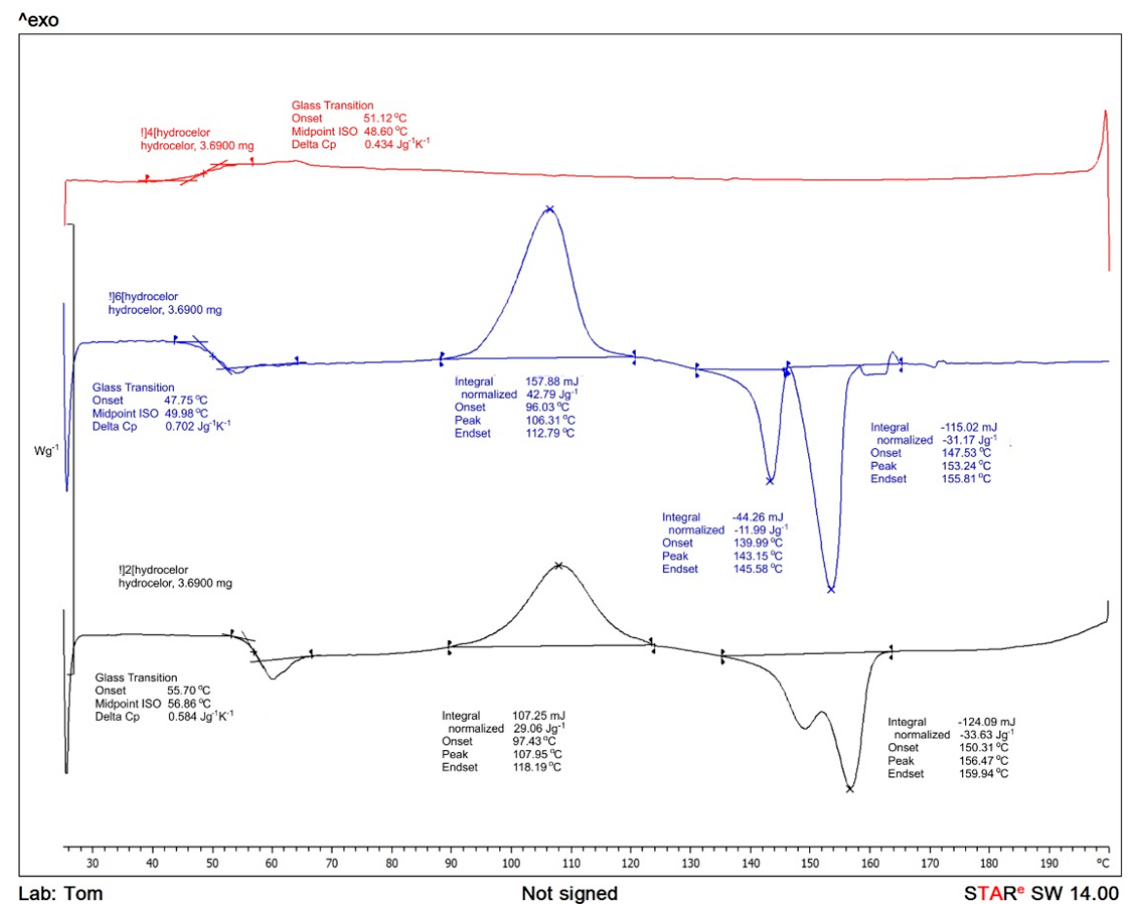
Figure 5. Thermal curves of expanded microporous PLA with blowing agent Hydrocerol 530.